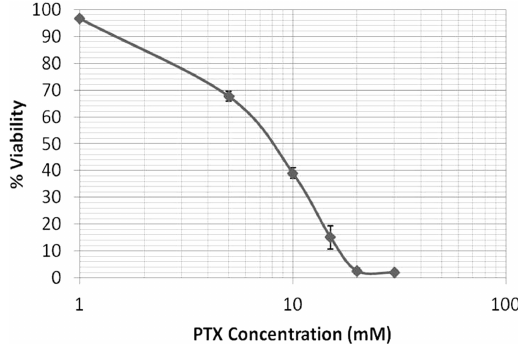
Fig. 3. Cell viability assay. Cells were seeded in 96-well format and di®erent doses of PTX (1 – 30 mM) were added for 24 h. After, overnight incubation on adding Kinetic blue, absorbance was recorded at 570 – 600 nm. Results were plotted in log scale where x -axis represent % Viability and y -axis corresponds to PTX concentration